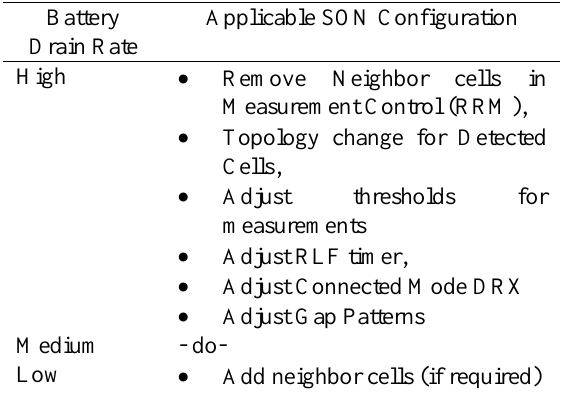
TABLE 2. C ONNECTED MODE - BATTERY DRAIN REPORT Battery Drain